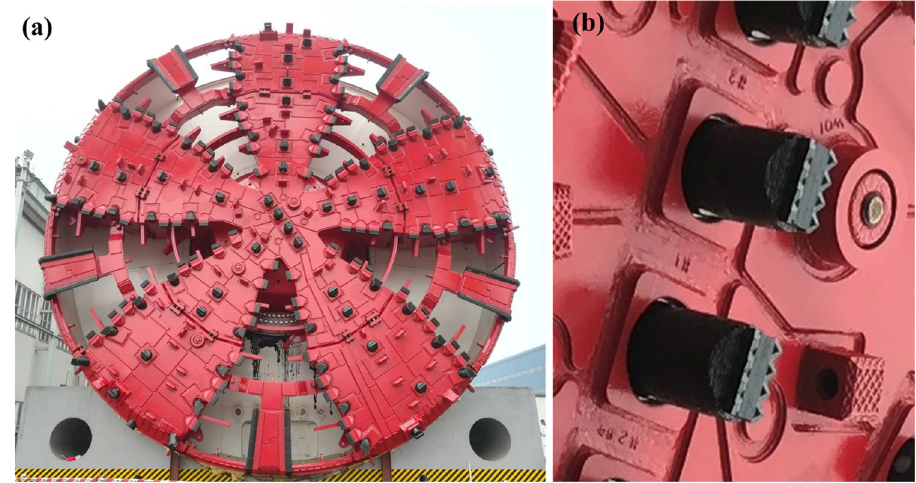
Figure 7. Cutterhead and cutter of the large-diameter slurry balance TBM: ( a ) cutterhead, ( b ) normal pressure replaceable